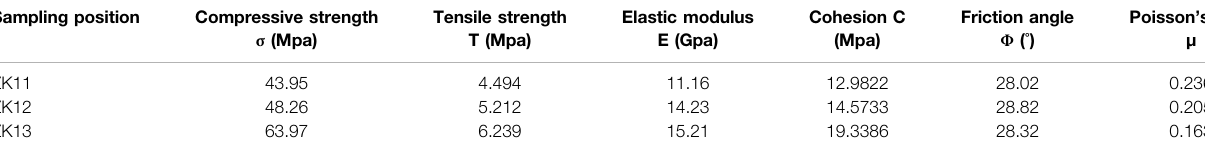
TABLE 1 | Rock mechanical parameters at the sampling point. Sampling position